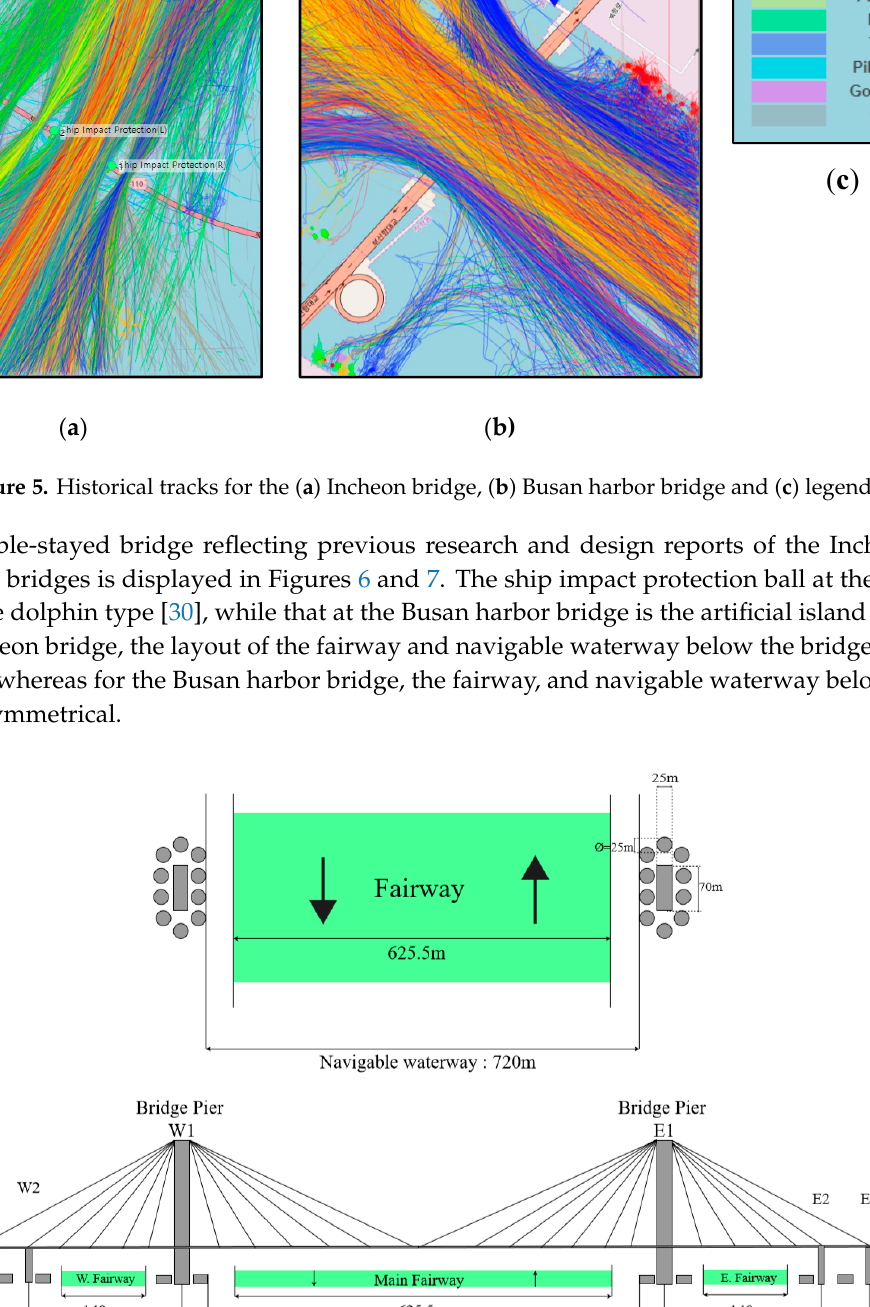
Figure 7. Cable-stayed part of Busan harbor bridge. 3. Traffic Distribution Characteristics 3.1. Statistical Power Analysis In this study, traffic distribution characteristics were analyzed for comparison, considering differences in the layout of the fairway and the bridge across the waterway, which were designed according to the ports. Before comparison the traffic distribution characteristics, a sample size statistical power analysis was performed according to the effect size to assess whether the acquired data involve sufficient statistical verification capabilities. The effect size refers to the degree of association between two means divided by the standard deviation of the data, indicating the extent of a phenomenon in a population. This is also termed as Cohen’s d and is expressed in following equation as: